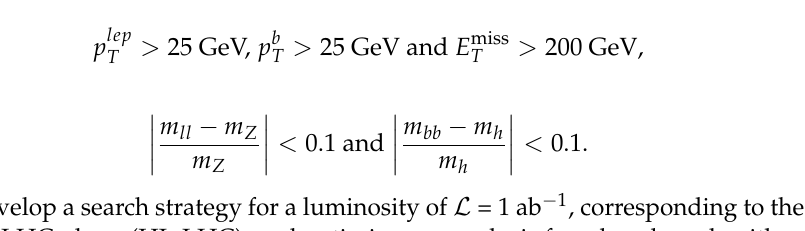
Figure 4. Distributions of the invariant mass of a pair of OS leptons m ll ( left panel) and a pair of b -jets m bb ( right panel) over samples of signal and backgrounds without parton-level